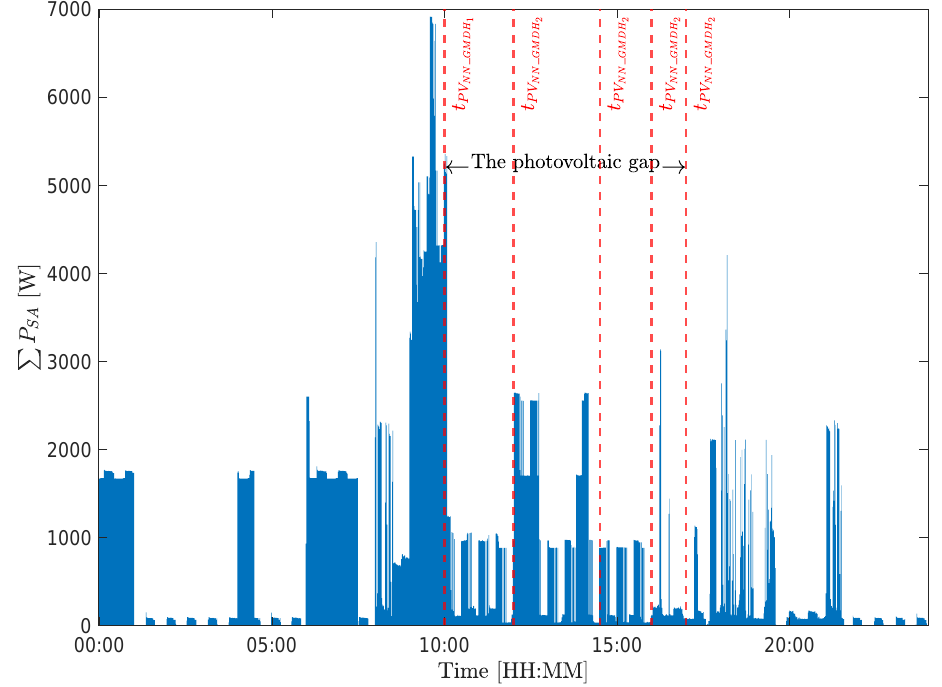
Figure 5. Total values of power consumption ( ∑ P SA ) by all